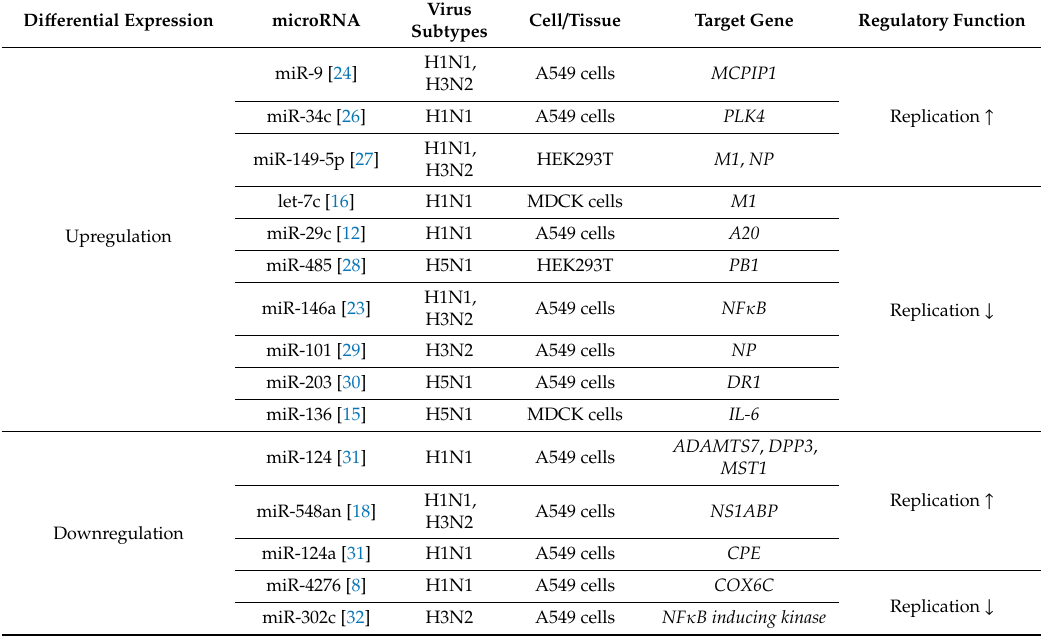
Table 2. List of major up- and down-regulated miRNAs in IAV infection during the viral life cycle. Di ff erential